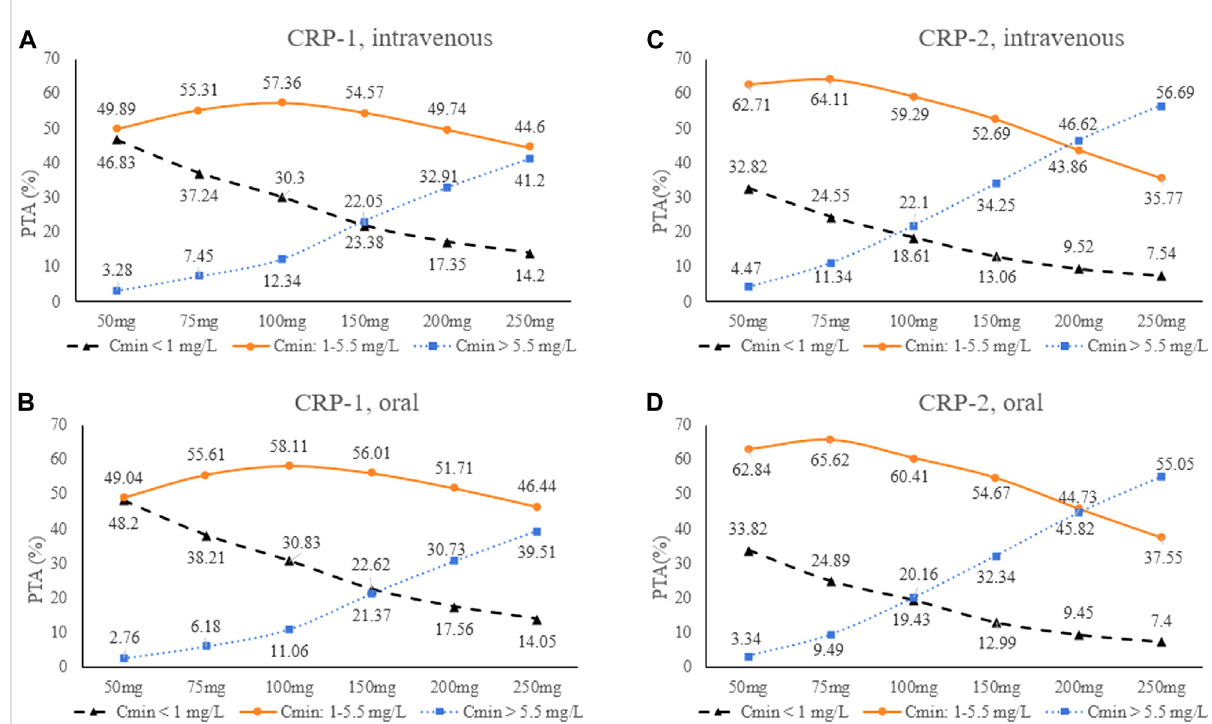
FIGURE 4 TroughconcentrationsdistributionatdifferentVRCmaintenancedosesforthefourscenarios. (A) :CRP-1,intravenous; (B)